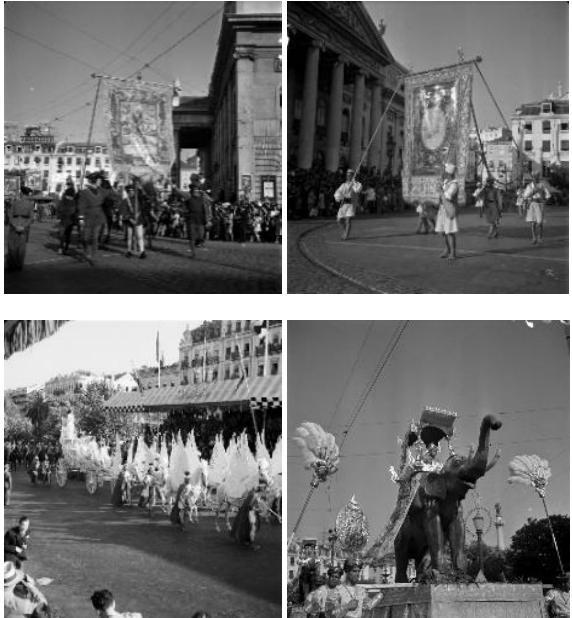
Figure 1 – Photographs of “Cortejo Histórico de Lisboa” in 1947, by the photographer Judah Benoliel.